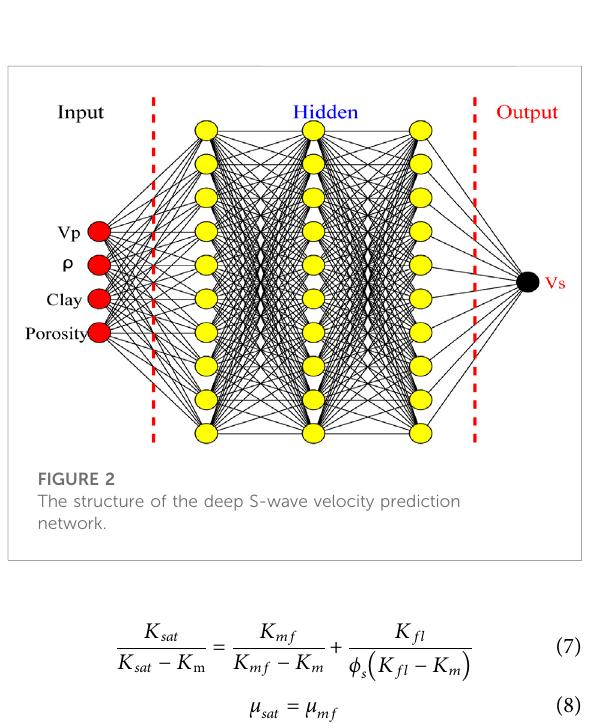
FIGURE 2 The structure of the deep S-wave velocity prediction network.